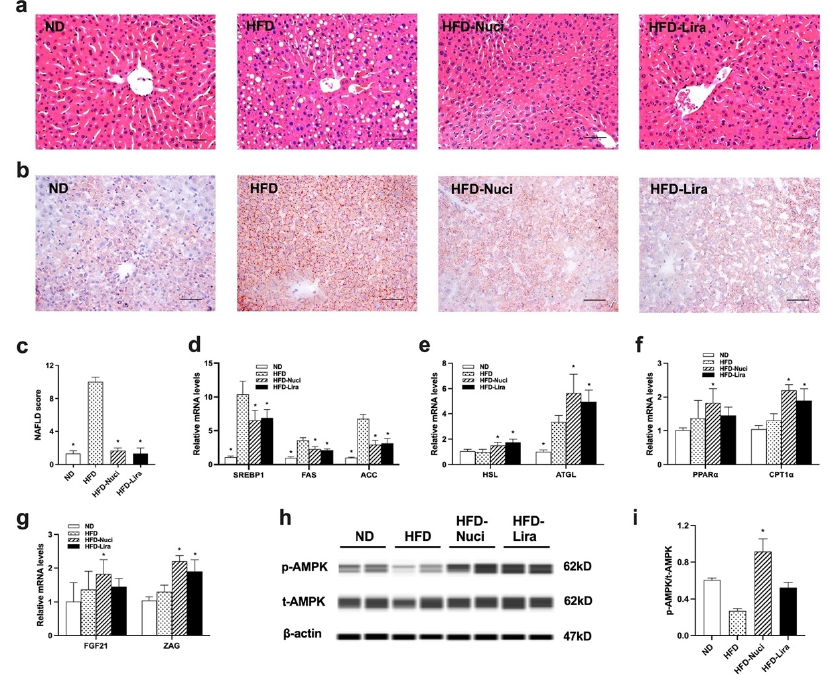
Figure 4. Nuci ameliorated hepatic steatosis by activating AMPK phosphorylation in liver of HFD-fed mice. Seven-weeks male C57BL/6J mice were fed with ND, HFD, HFD supplemented with Nuci and HFD with subcutaneous injection of Lira at 200 μ g/kg/day for 12 weeks. H&E-staining ( a ) and Oil-red O staining ( b ) images of representative sections of mice liver in the ND, HFD, HFD-Nuci, and HFD-Lira group; photographs were taken at 200× magnification. NAFLD scores of the four groups according to a general NAFLD scoring system for rodent models ( c ). The mRNA expressions of lipogenesis-related genes SREBP1, FAS, and ACC ( d ), lipolysis-related genes HSL and ATGL ( e ), fatty acid oxidation-related genes PPAR α and CPT1 ( f ), and adipokines FGF21 and ZAG ( g ) were determined by RT-qPCR. The protein levels of p-AMPK, t-AMPK and β -actin were analyzed by Simple western ( h ). the expression of p-AMPK was normalized against t-AMPK ( i ). Data were presented as mean ± SE, n = 12 in each group. * p < 0.05 vs. the HFD group.